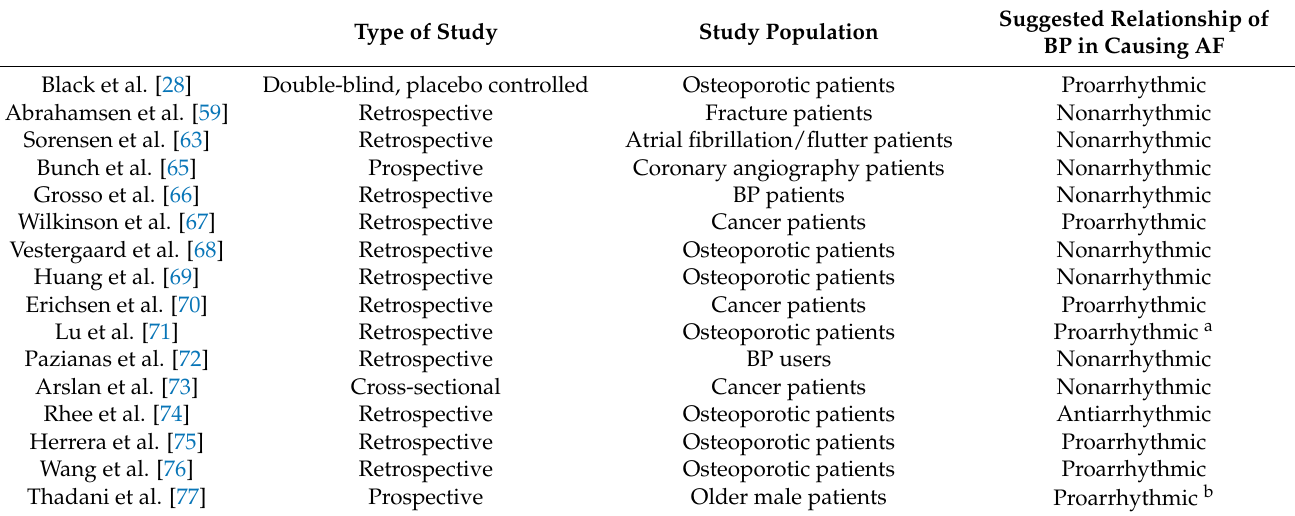
Table 1. Summary of clinical epidemiological studies investigating the relationship between BPs